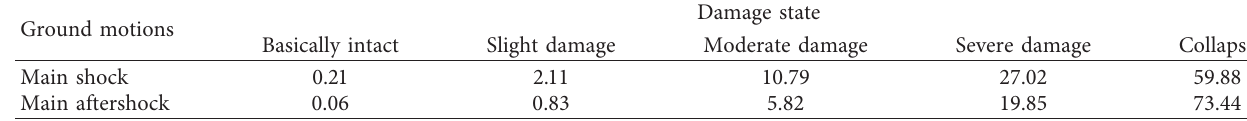
Table 9: Probability of the structure being in various damage states (%). Ground motions